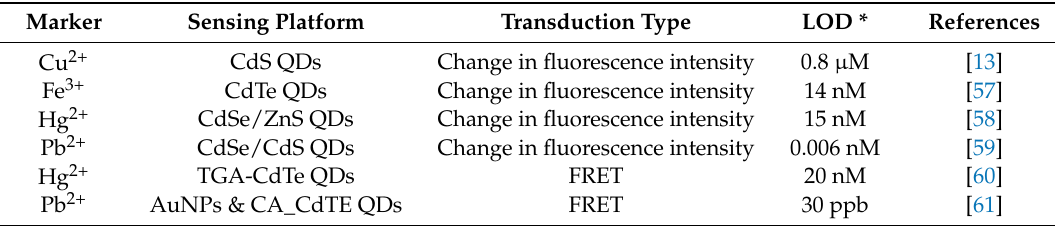
Table 1. QDs-based sensors for heavy metal ions determination.